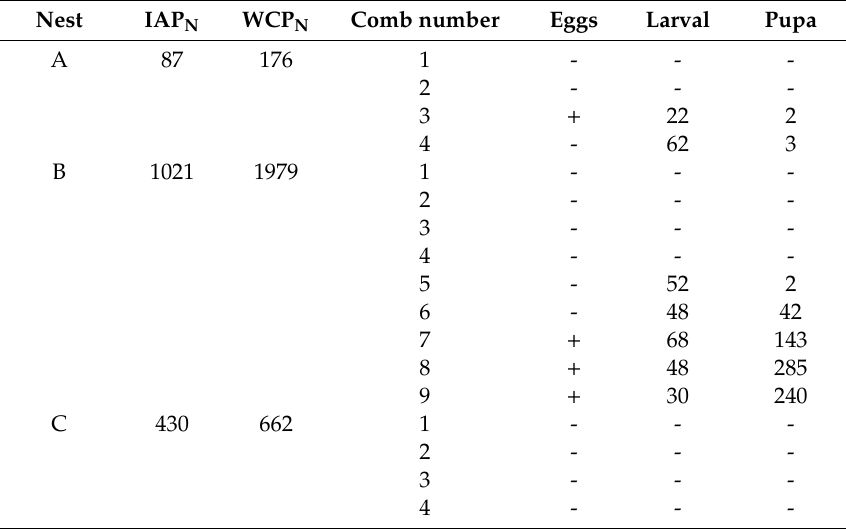
Figure 6. Nest C shows a yellow pollen-like material found inside a pocket. Table 3. Nest colony composition of the V. velutina nests studied. Insect adult population (IAP N ) and whole colony population (WCP N